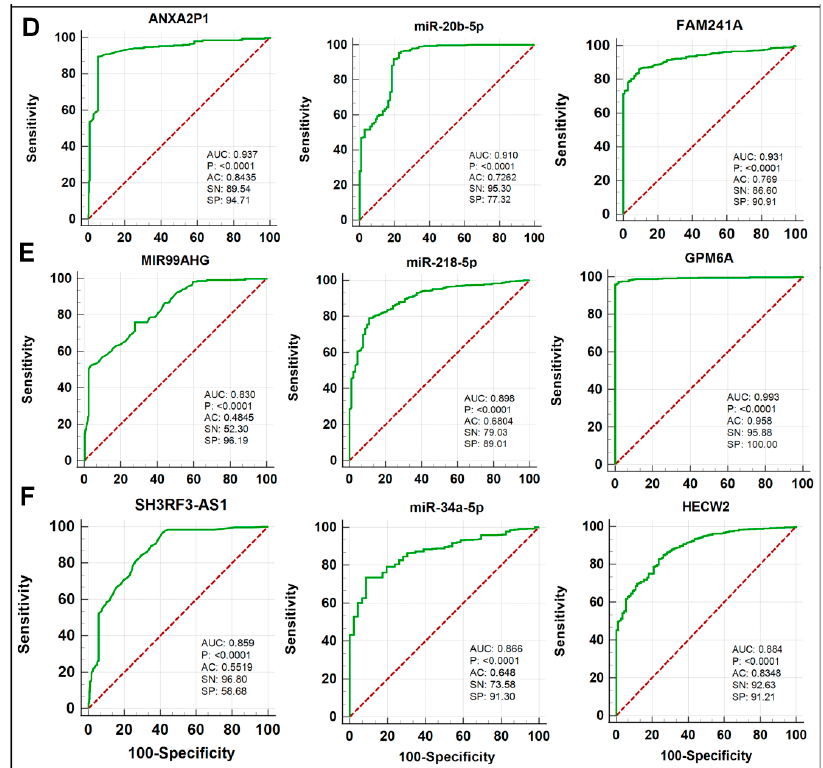
Figure 9. ROC curve and diagnostic performance of ceRNA modules in lung cancer. The ROC curve analysis of oncogenic and tumor suppressor regulatory axes ( A – C ) and ( D – F ), respectively. AC: accuracy; SN: sensitivity; SP: